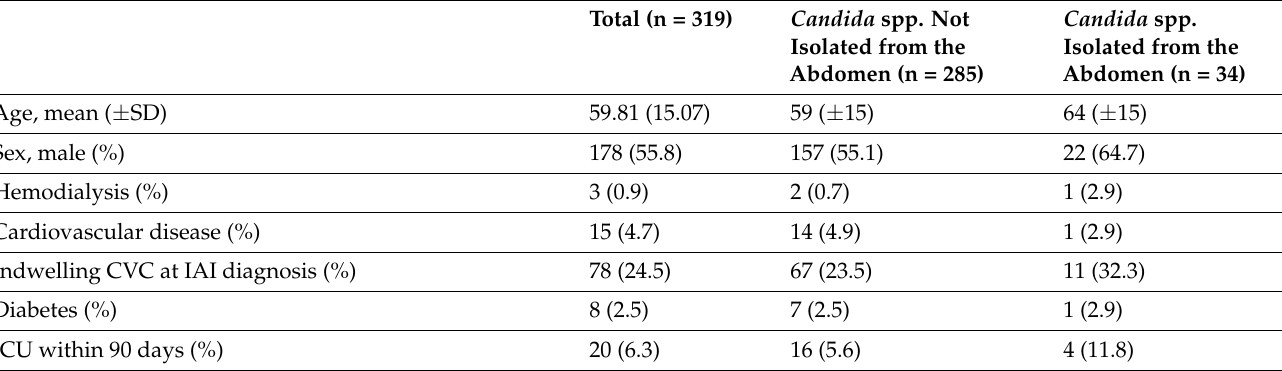
Table 1. Characteristics of the patient